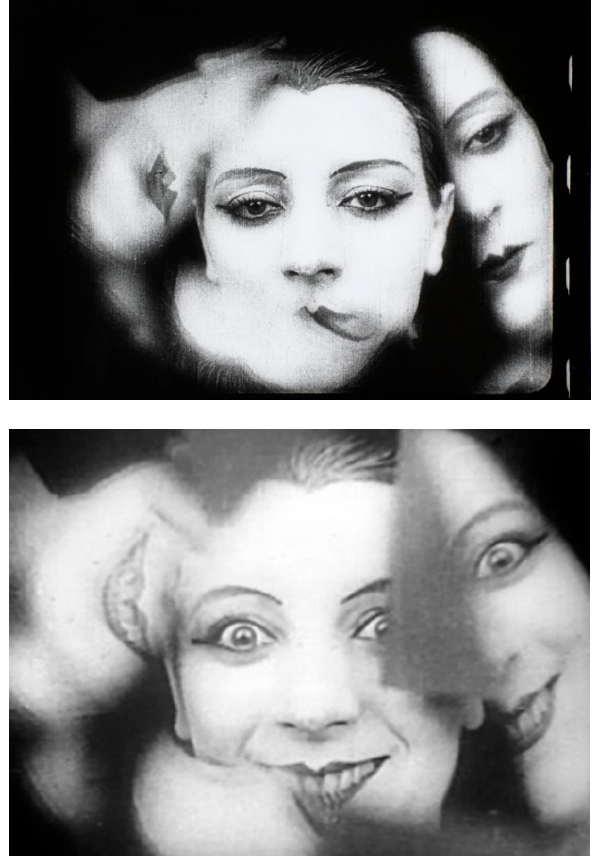
Figure 6. Le Ballet mécanique by Fernand Léger & Dudley Murphy, 1924 (two stills showing Kiki de Montparnasse). 19’50” 35 mm black & white film acquired 1997, inventory number AM 1997-F1388. Centre Pompidou, Musée national d’art modern , Paris. © Centre Pompidou, MNAM-CCI/Service de la documentation photographique du MNAM/Dist. RMN-GP Â© Adagp, Paris, 2017 and used by